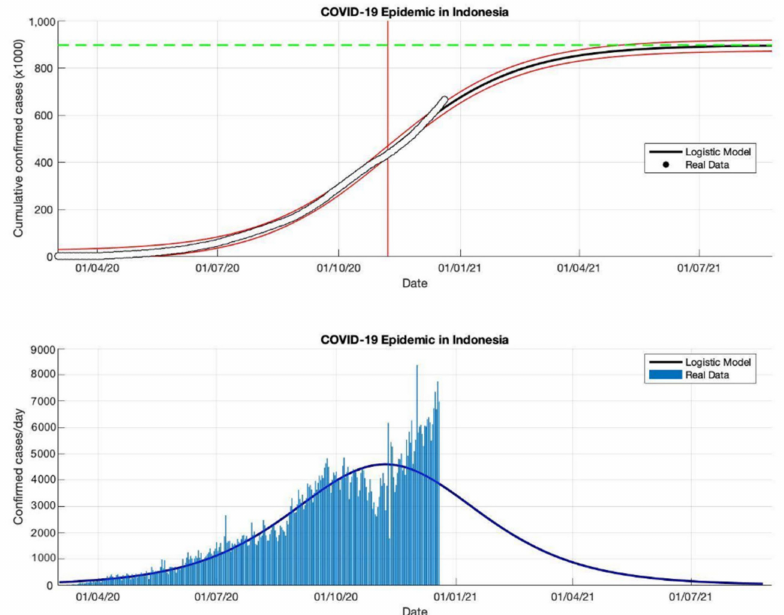
Figure 19. In the above figure, the prediction results of the logistic growth model for cumulative infected cases are compared with the actual data, while the two red lines between the black lines represent a prediction error limit of about 5%. The dashed green line predicts the total size of infected cases in the final phase of the epidemic. The red line intersects the cumulative case curve to predict the turning point or peak point of the epidemic (this line is parallel to the top of the curve from the below figure). In the below figure, the prediction results of this model for daily infected cases